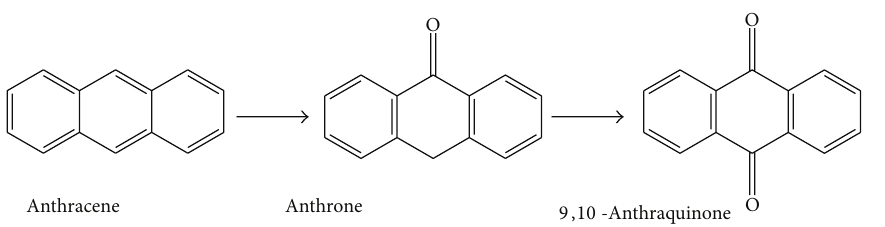
Figure 11: Proposed pathway degradation of